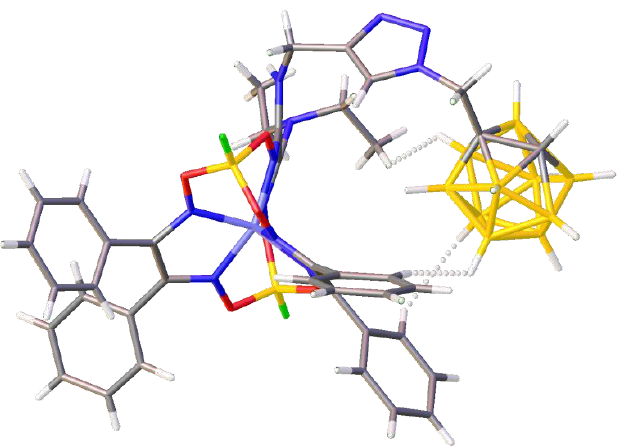
Figure 1. General view of molecule 15 (the solvent benzene molecule is not shown for clarity). The intramolecular interactions are shown with dotted lines.